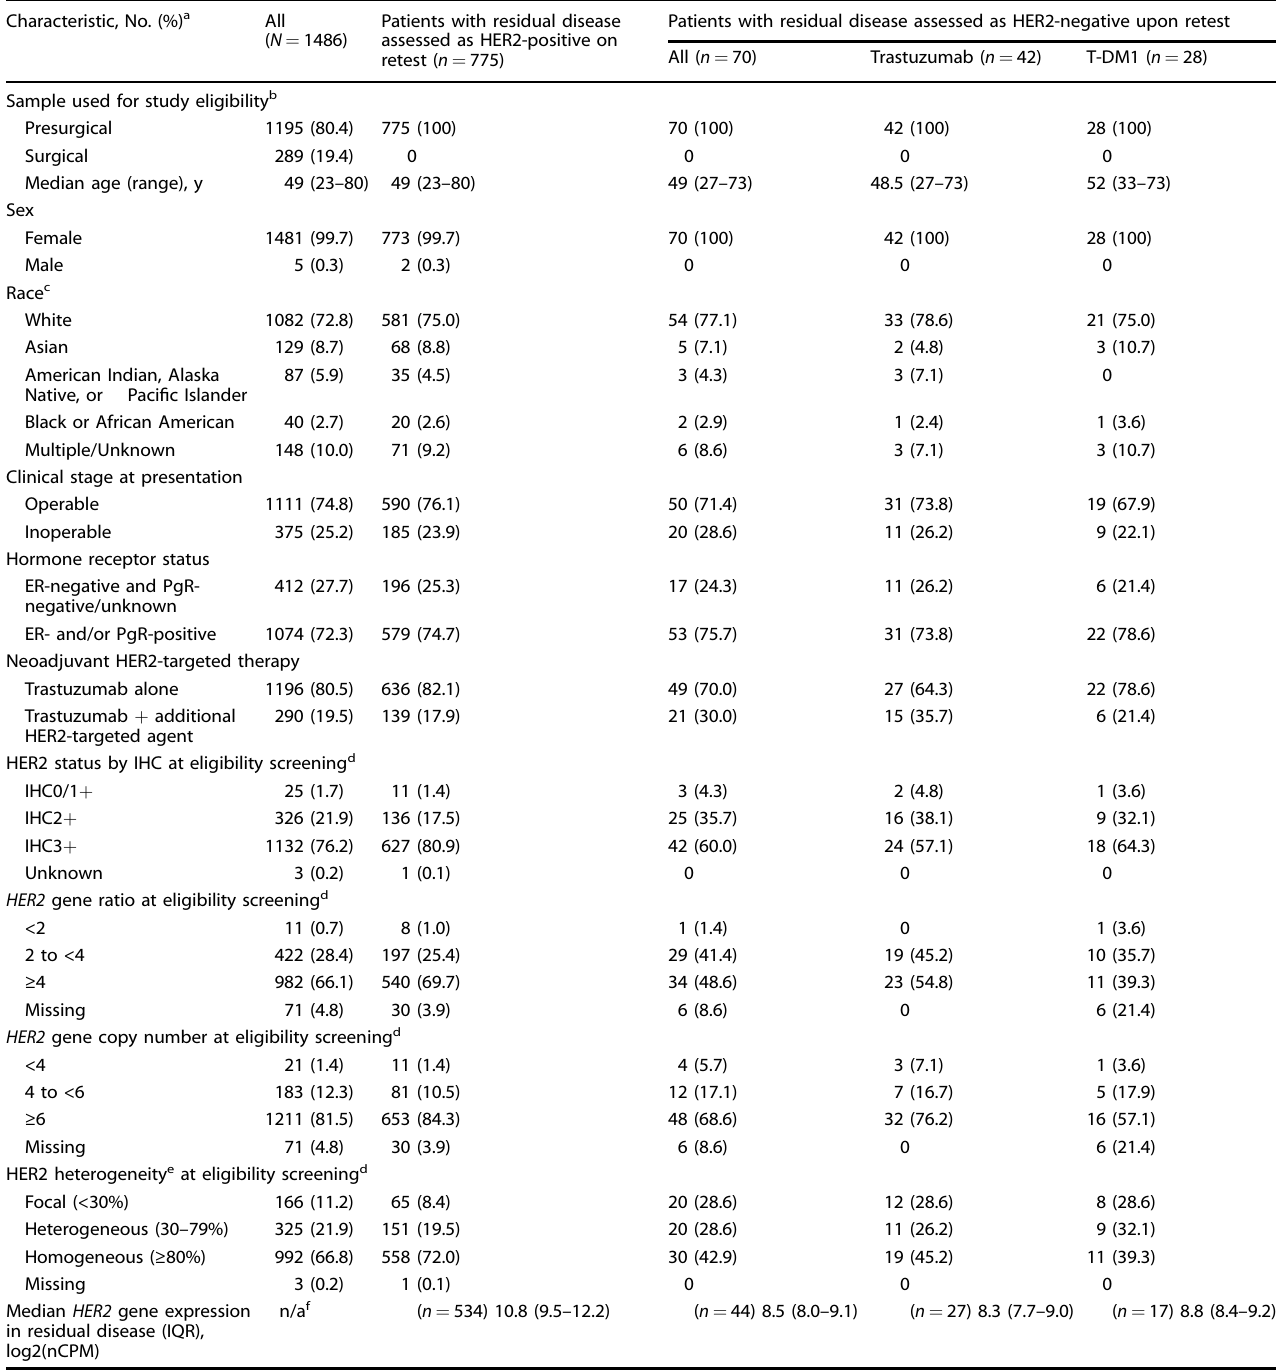
Table 1. Baseline characteristics by HER2 status in residual disease at surgery after neoadjuvant systemic therapy. Characteristic, No. (%)